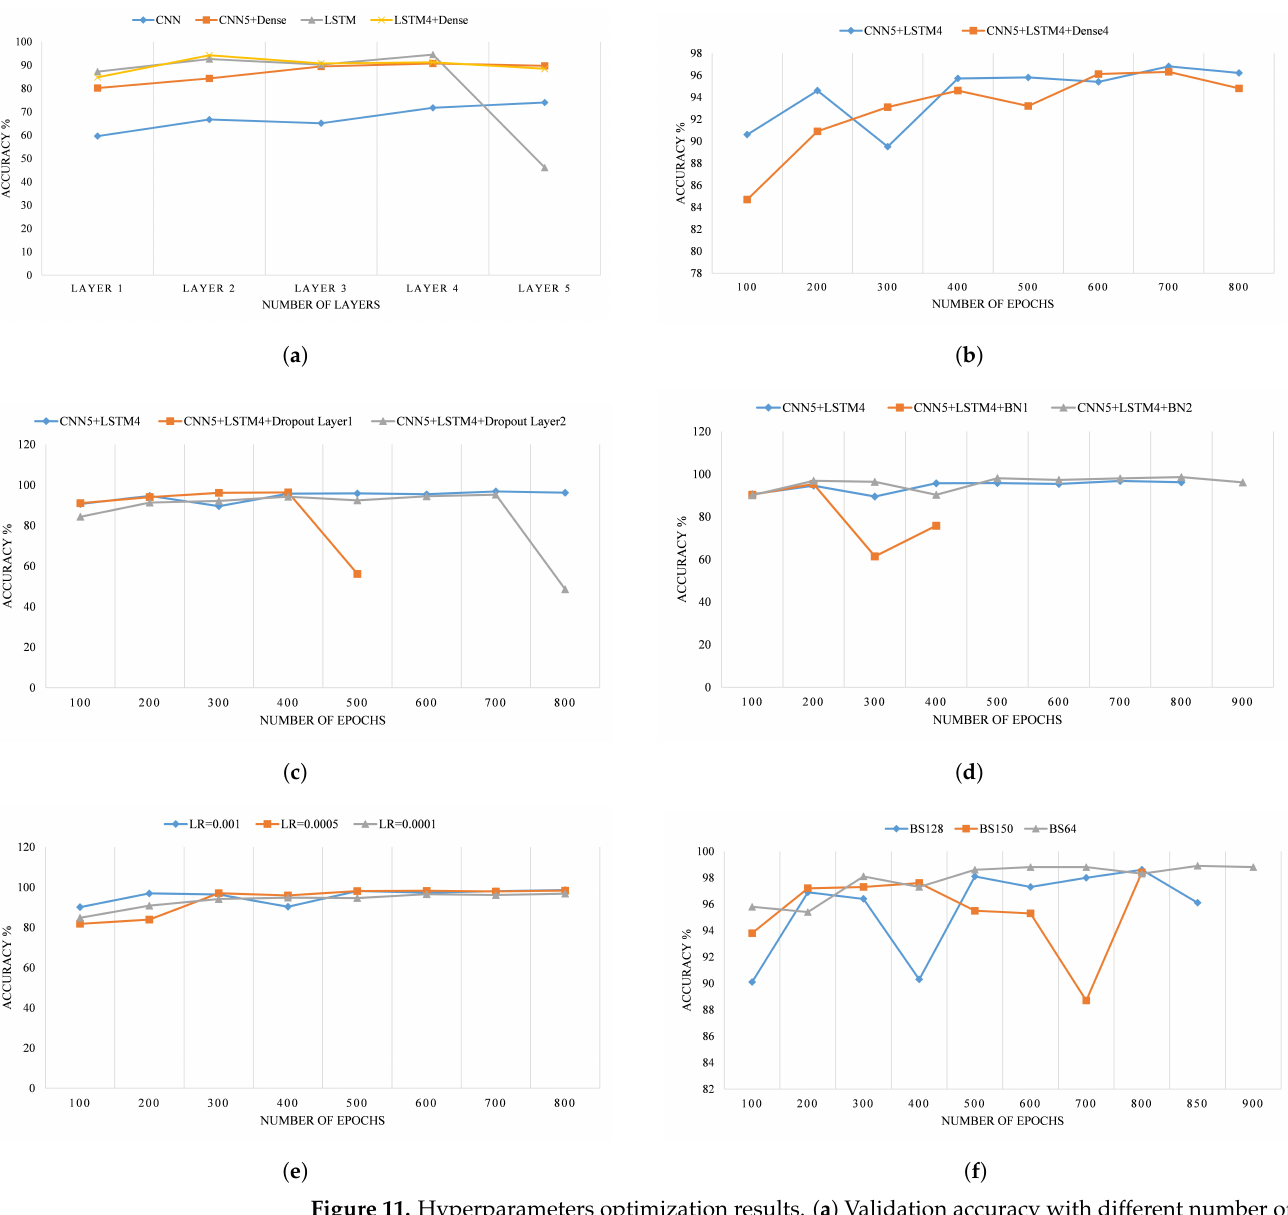
Figure 11. Hyperparameters optimization results. ( a ) Validation accuracy with different number of layers. ( b ) Validation accuracy with different number of epochs. ( c ) Validation accuracy with different number of dropout layers. ( d ) Validation accuracy with different number of batch normalization layers. ( e ) Validation accuracy with different number of learning rate. ( f ) Validation accuracy with different number of batch size